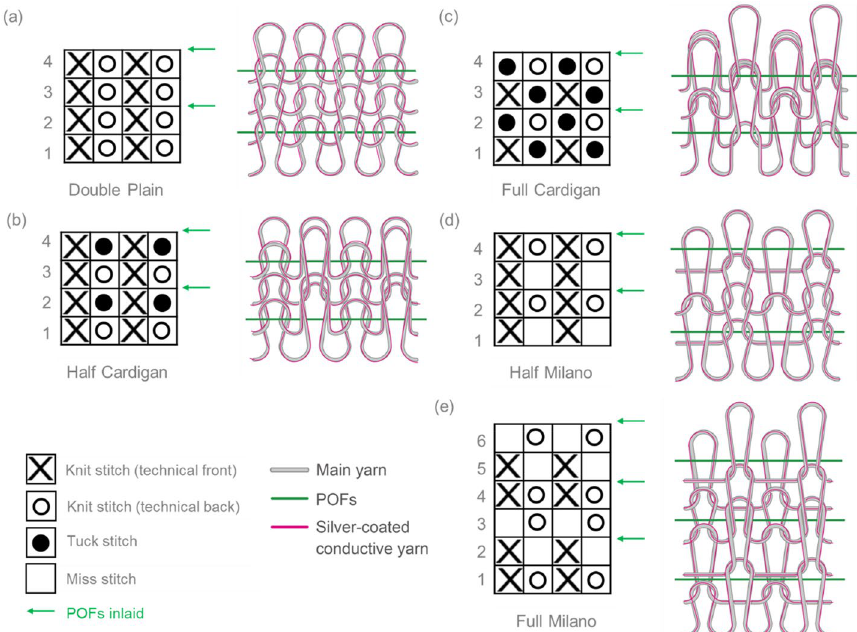
Fig. 2 Diagram showing the stitch notations and illustrations of five double-knitted structures with the indication of polymeric optical fibre (POF) inlaid: a double plain; b half cardigan; c full cardigan; d half Milano; and e full